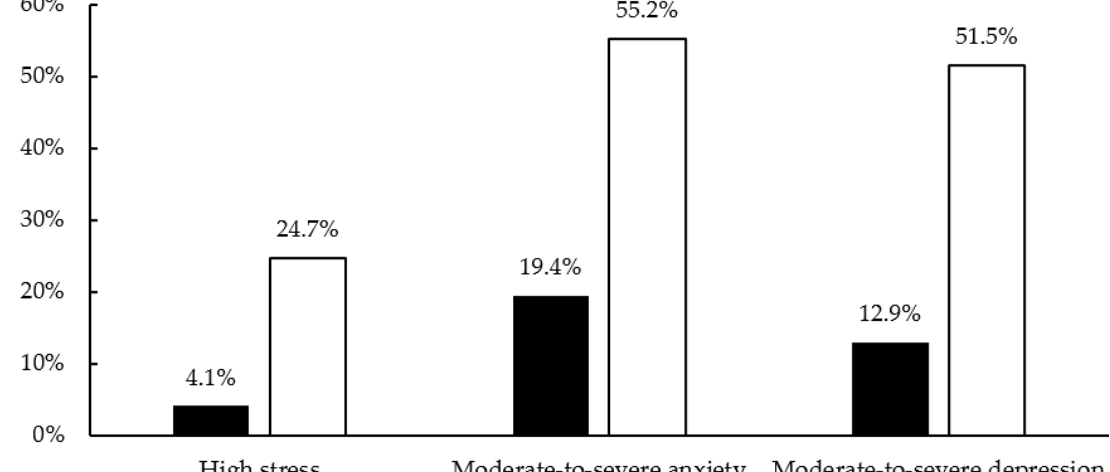
Figure 1. Poor mental health status before and during COVID-19 lockdown ( N = 173). Black bars and white bars represent the poor mental health status before and during the COVID-19 lockdown, respectively. High stress = Perceived Stress Scale scores ≥ 27; moderate-to-severe anxiety = GAD-7 scores ≥ 10; moderate-to-severe depression = PHQ-9 scores ≥ 10.